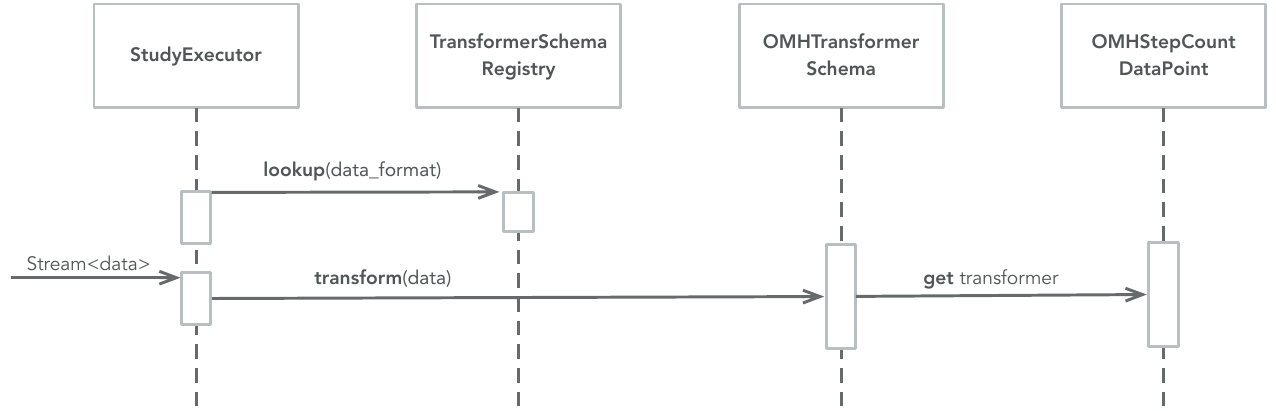
Figure 5. The UML interaction diagram of the transformation phase of the data transformation